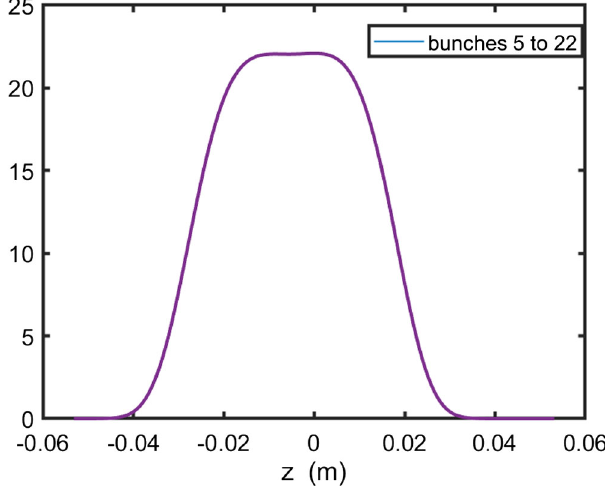
FIG. 15. The bunch population factor ξ ð j Þ of Eq. (82) for b ¼ 1 . 7 and n 13 g ¼